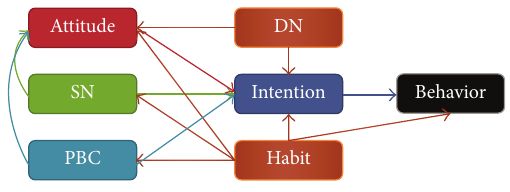
Figure 4: Impact of habit in TPB. Table 1: Socioeconomic status